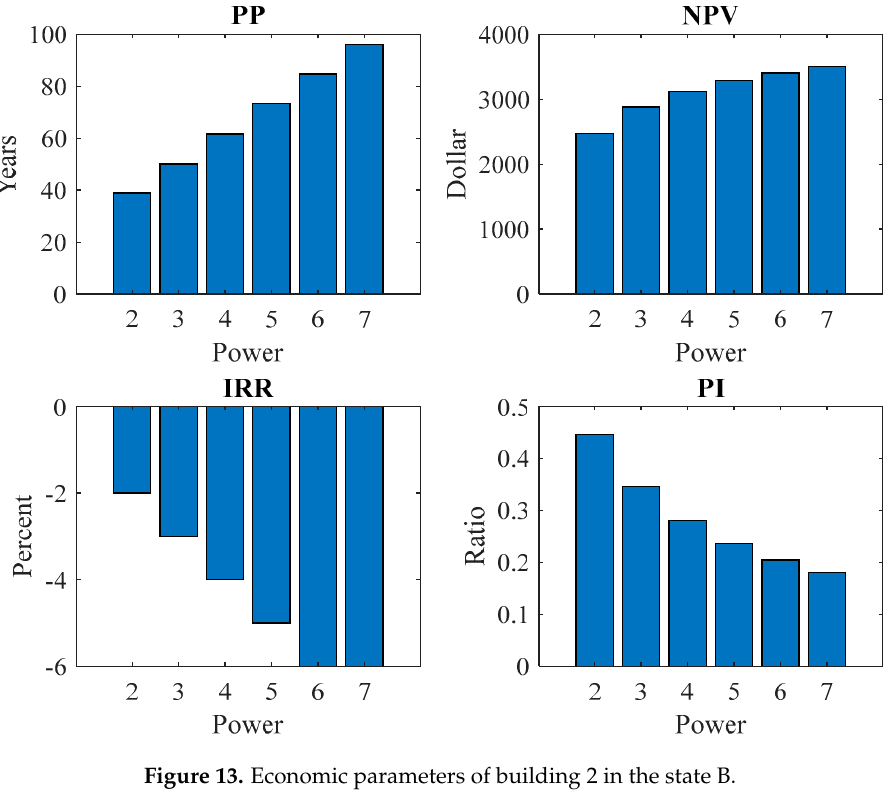
Figure 13. Economic parameters of building 2 in the state B.